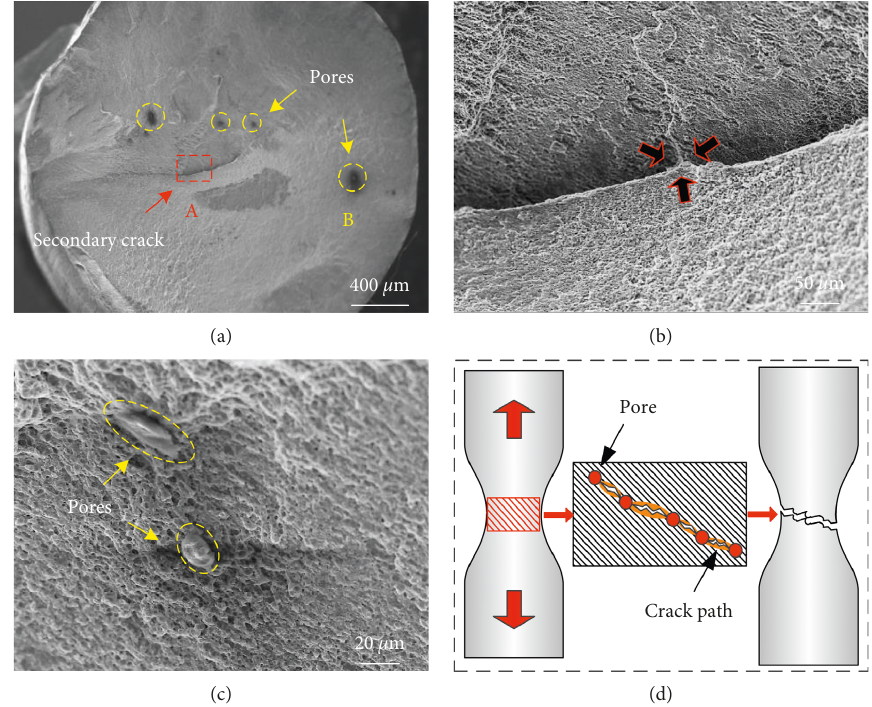
Figure 8: The fracture morphology of the ϕ 5.2 mm wire with hydrogen content of 0.38 μ g/g. (a) Macroscopic morphology of the fracture; (b) and (c) microscopic view of the fracture surface; (d) schematic diagram of pores leading to the formation of cracks.